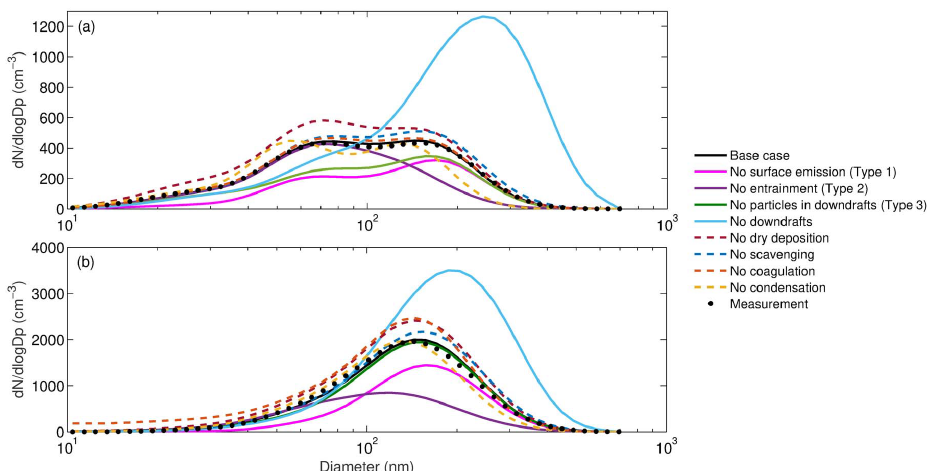
Figure 4. Modeled average particle number sized distributions for (a) the wet season and (b) the dry season. Shown are: the base case model runs, where all processes listed in Table 2 were considered; simulations without the Type 1 surface source of particles; simulations without the Type 2 source of particles entrained from above the BL; simulations with particle-free air in the convective downdrafts (Type 3); no convective downdrafts; no particle dry deposition losses; no below cloud scavenging; no coagulation; and no condensation. The measured median particle number size distributions are also